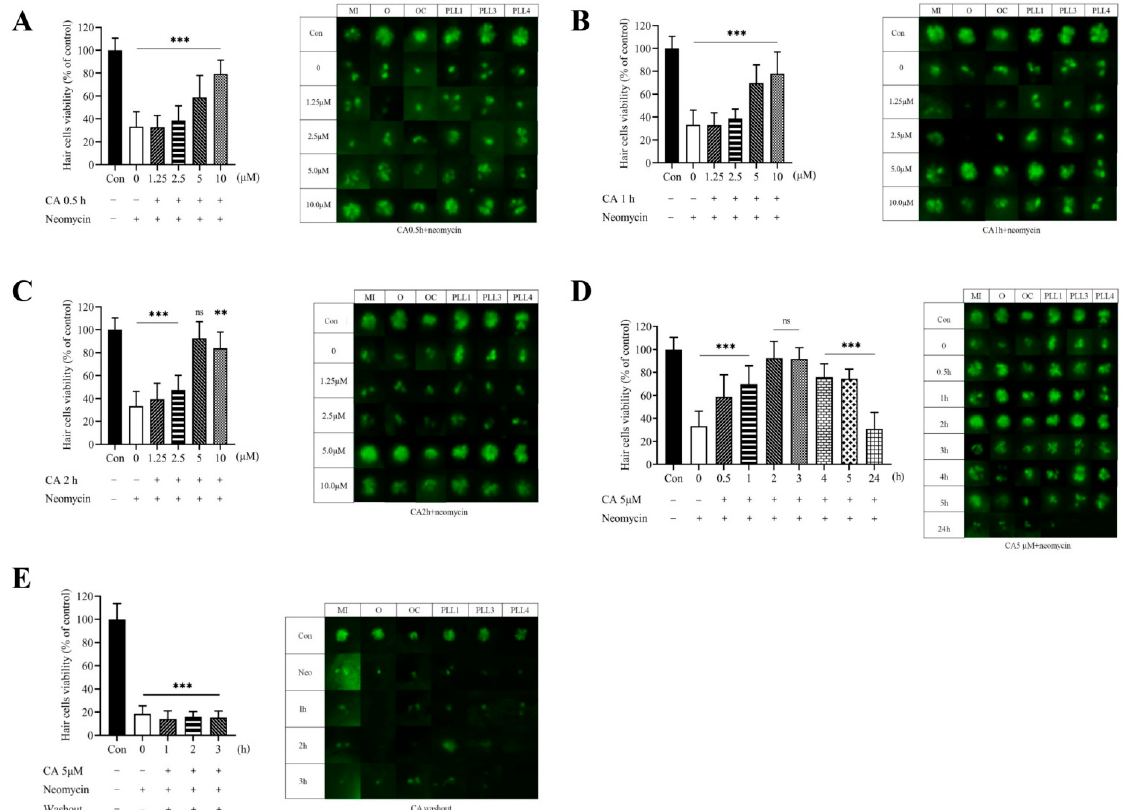
Figure 2. CA protected against neomycin-induced lateral line hair cell loss. ( A ) Transgenic zebrafish larvae were fixed and photographed using a fluorescence microscope. 7-dpf transgenic zebrafish larvae were treated with 12.5 µ M of neomycin only for 0.5 h or pre-treated with CA (0, 1.25, 2.5, 5, and 10 µ M) for 0.5 h, ( B ) 1 h, and ( C ) 2 h, respectively. ( D ) 7-dpf transgenic zebrafish larvae were treated with 12.5 µ M of neomycin only for 0.5 h or pretreated with 5 µ M CA for different times (0, 0.5, 1, 2, 3, 4, 5, and 24 h). ( E ) 7-dpf transgenic zebrafish larvae were pretreated with 5 µ M of CA for 1, 2, and 3 h followed by CA washout, and subsequently 0.5 h of 12.5 µ M neomycin treatment. Fluorescence micrographs of lateral line hair cells from neuromasts (O, OC, MI, PLL1, PLL3, and PLL4) (right panel) were analyzed and the quantitative result of viable hair cells was present as a percentage of the untreated control (left panel). All values of the experimental groups were presented as mean ± SD. ** p < 0.01, *** p < 0.001, and ns, no significant difference as compared with untreated